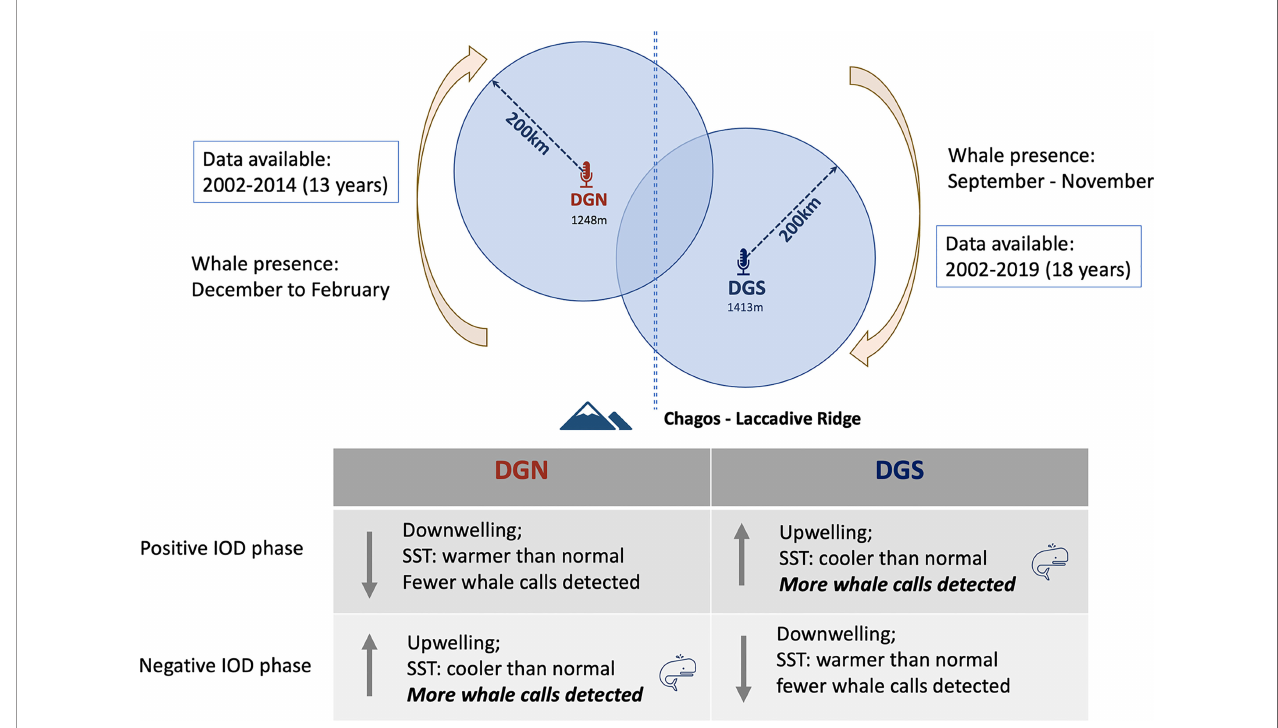
FIGURE 9 | Conceptual fi gure of the relationship between Indian Ocean Dipole (IOD) and whale song detected at DGN and DGS. Positive and negative IOD phases in fl uence in the Indian Ocean were described by Saji et al.,